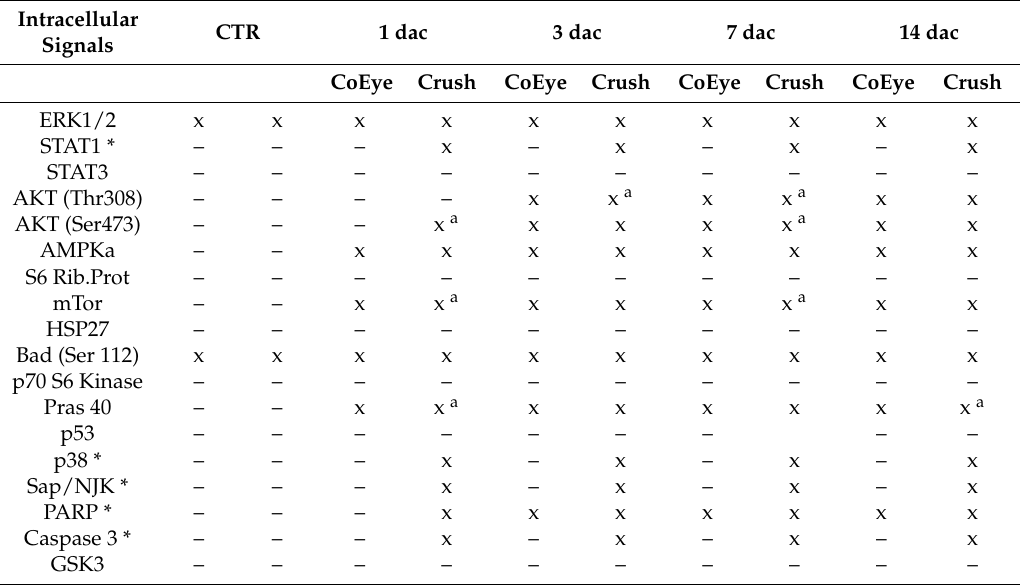
Table 1. Time course effect of nerve crush on the activation of intracellular signaling molecules in the